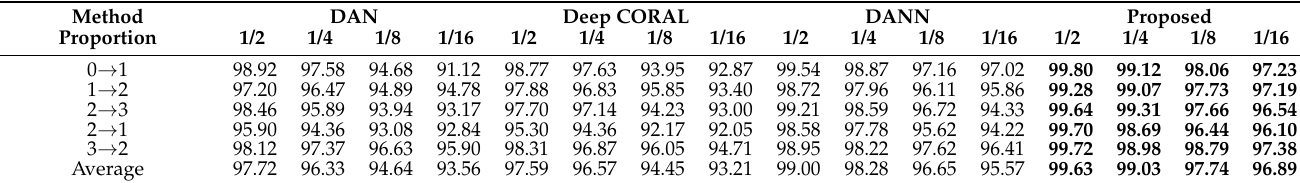
Table 5. Average testing accuracies in the fault detection of case study